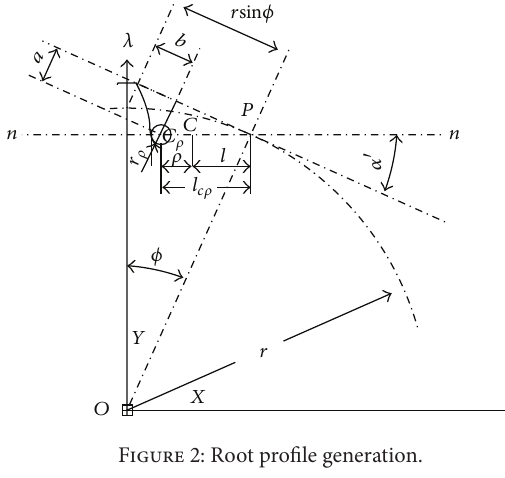
Figure 2: Root profile generation.